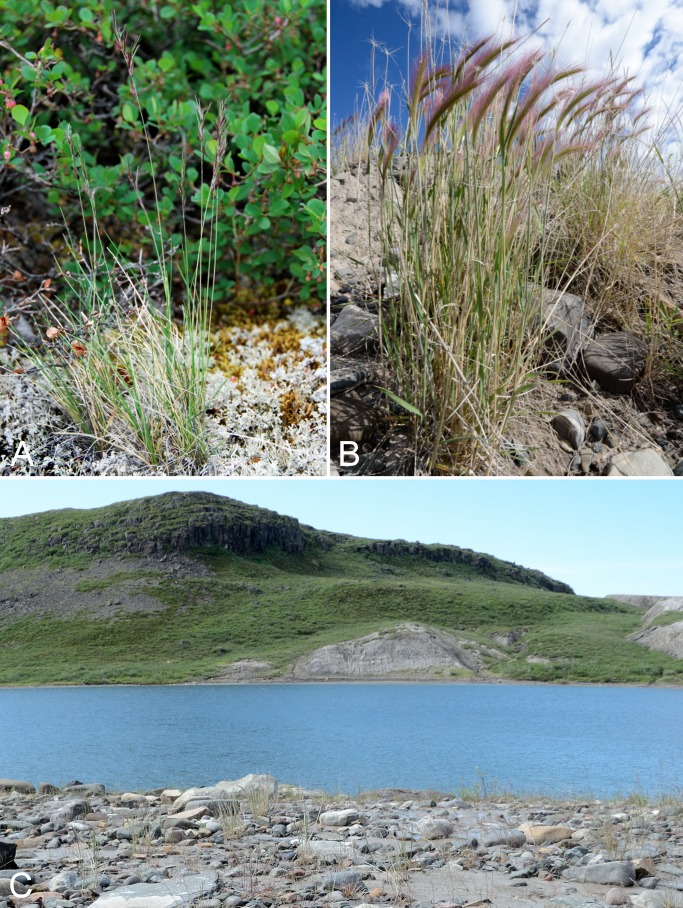
Festuca viviparoidea and Hordeum jubatum subsp. intermedium.Festuca viviparoidea: (A) habit, Saarela et al. 3938. Hordeum jubatum subsp. intermedium. (B) Habit, Saarela et al. 4213. (C) Habitat, Saarela et al. 4213. Photographs by J. M. Saarela (A) and R. D. Bull (B, C).